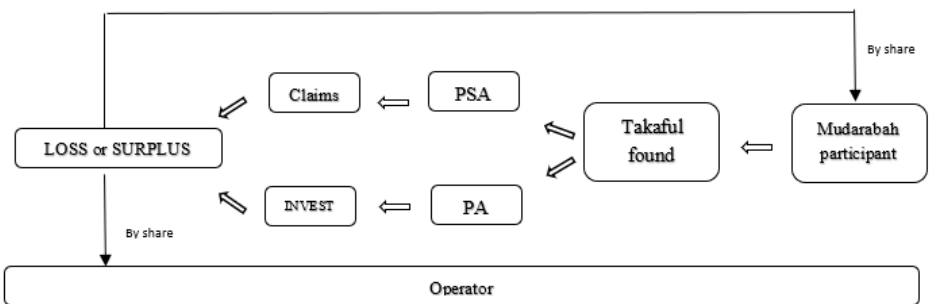
Figure 6. Takaful Mudarabah